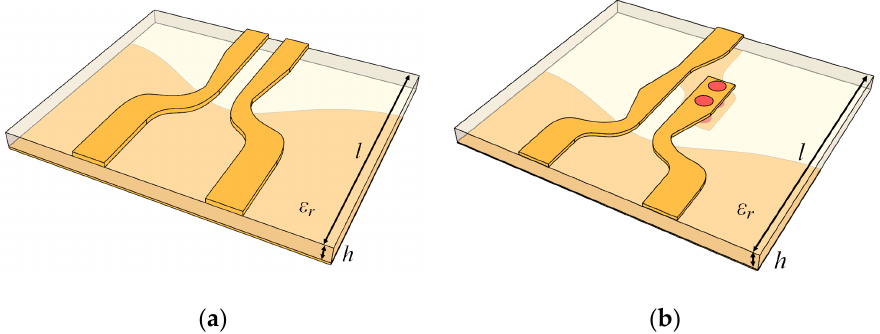
Figure 8. Perspective views of the proposed DL-to-BL transitions: ( a ) DL-to-CPS transition, ( b ) DL- to-PSL transition.